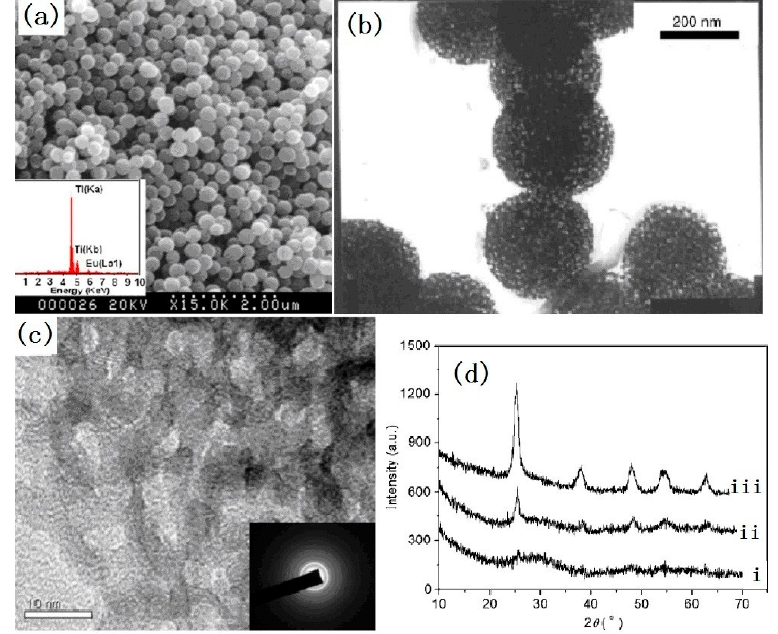
Figure 4. TEM photograph of mesoporous-doped TiO 2 and XRD patterns ( a ) before hydrothermal and acid treatment, ( b ) after hydrothermal and acid treatment of mesoporous-doped TiO 2 [64].